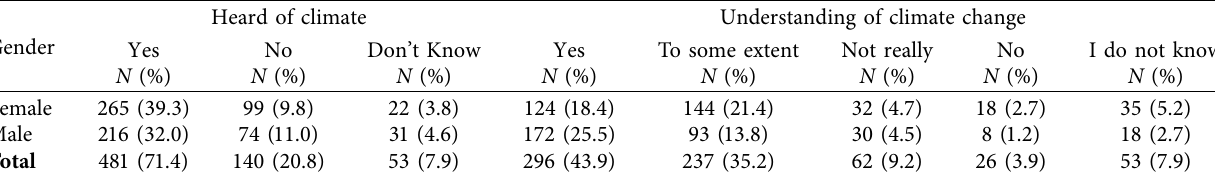
Table 3: Respondents’ perceptions of climate change causes. Cause N (%) Burning fossil fuel